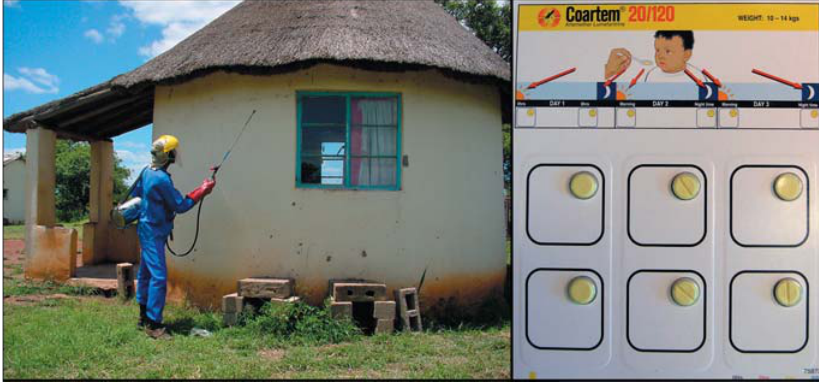
Figure 1. Mosquito Control and ACT Are Both Likely Contributors to the Reduction of Malaria in KwaZulu–Natal (Photo: Karen Barnes and Atis